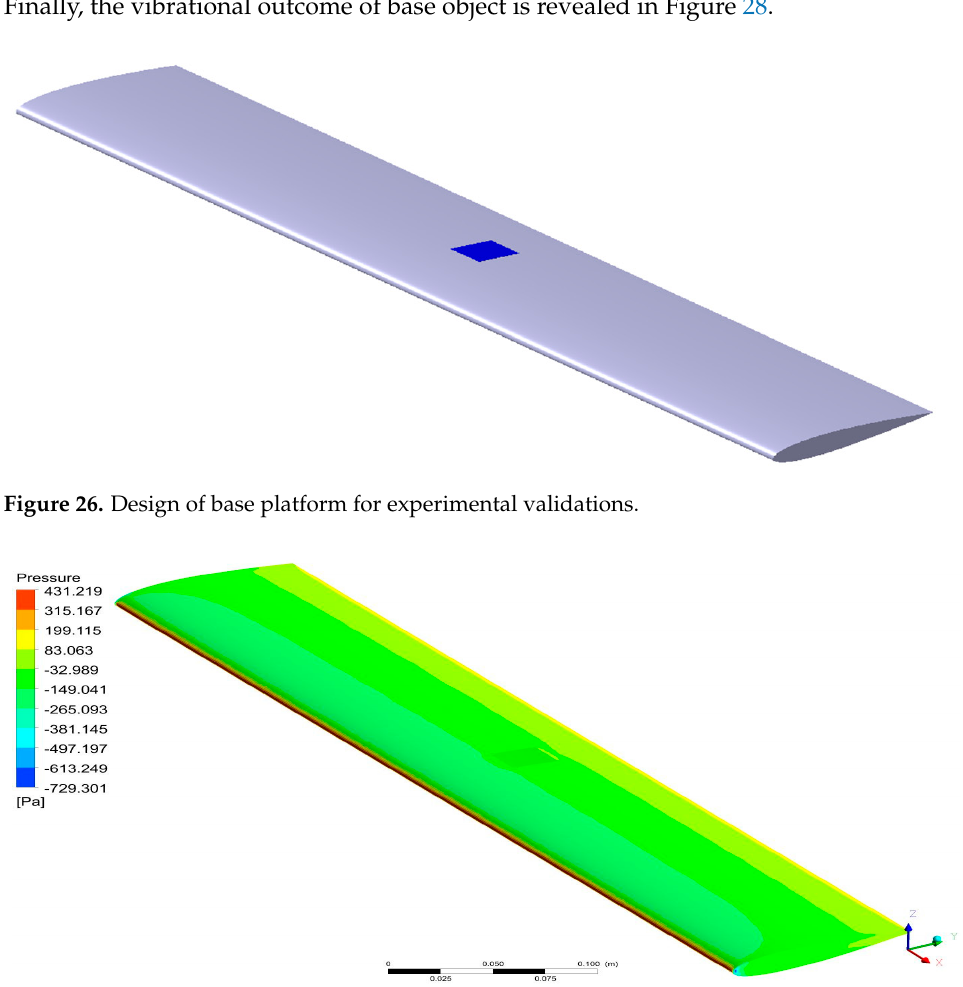
Figure 27. Pressure variations on base aircraft wing model for experimental validation.